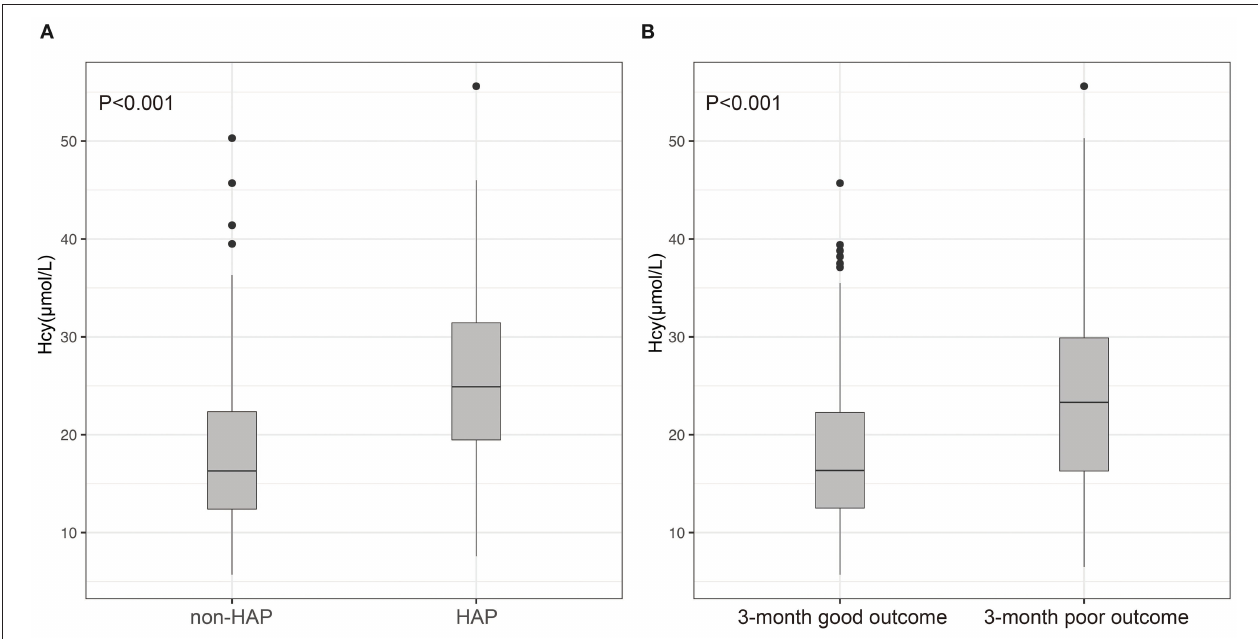
FIGURE 2 | Differences of Hcy between patients with ICH and with and without HAP (A) ; differences of Hcy between patients with ICH with 3-month good outcome and poor outcome (B) . (A) Compared with patients without HAP, levels of Hcy in those with HAP were significantly high ( p < 0.001); (B) patients with ICH having poor outcomes had much higher Hcy compared with those with good outcomes ( p <